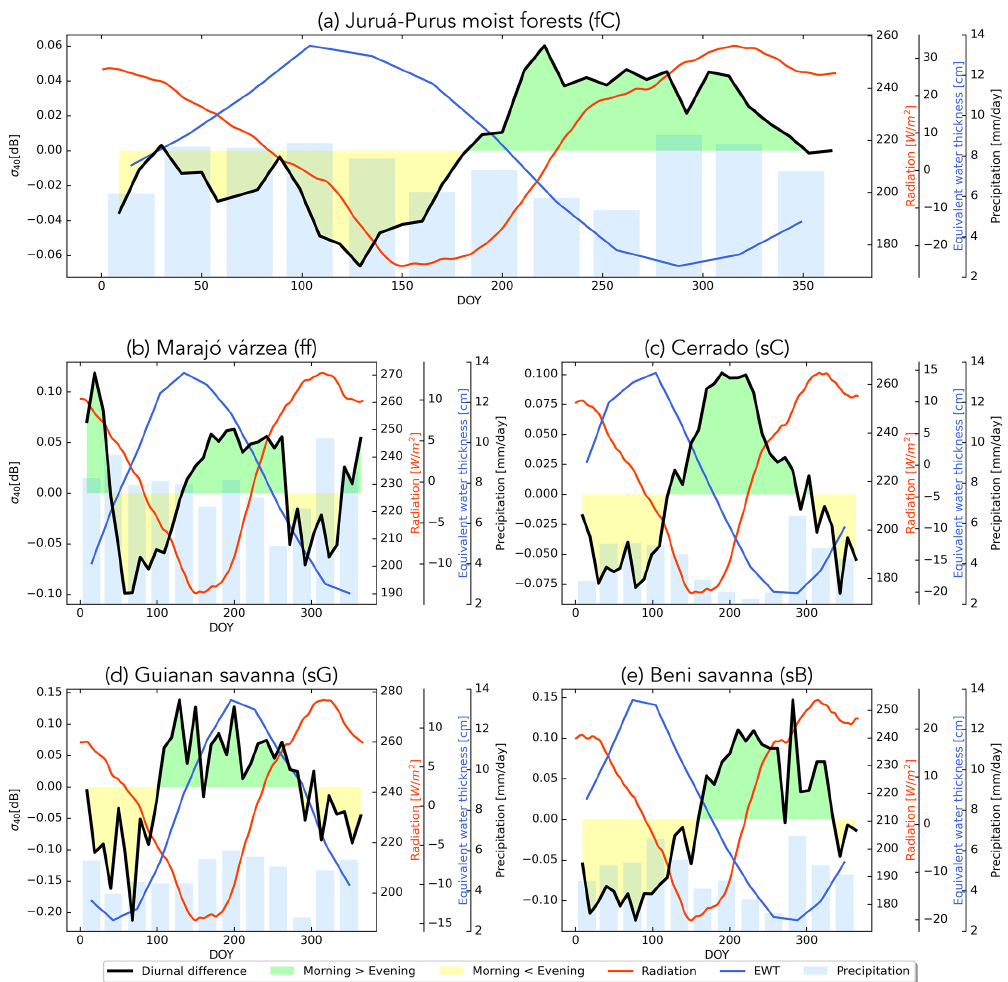
Figure 13. Seasonal cycle of diurnal difference in backscatter (black line), radiation (red line), EWT (blue line), and precipitation (bars) for different cover types. Green (yellow) fill indicates days on which backscatter is higher (lower) in the morning than in the